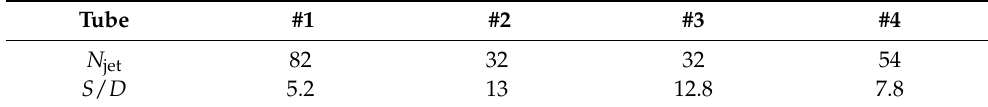
Table 1. Geometric parameters of the hole pattern on the panel